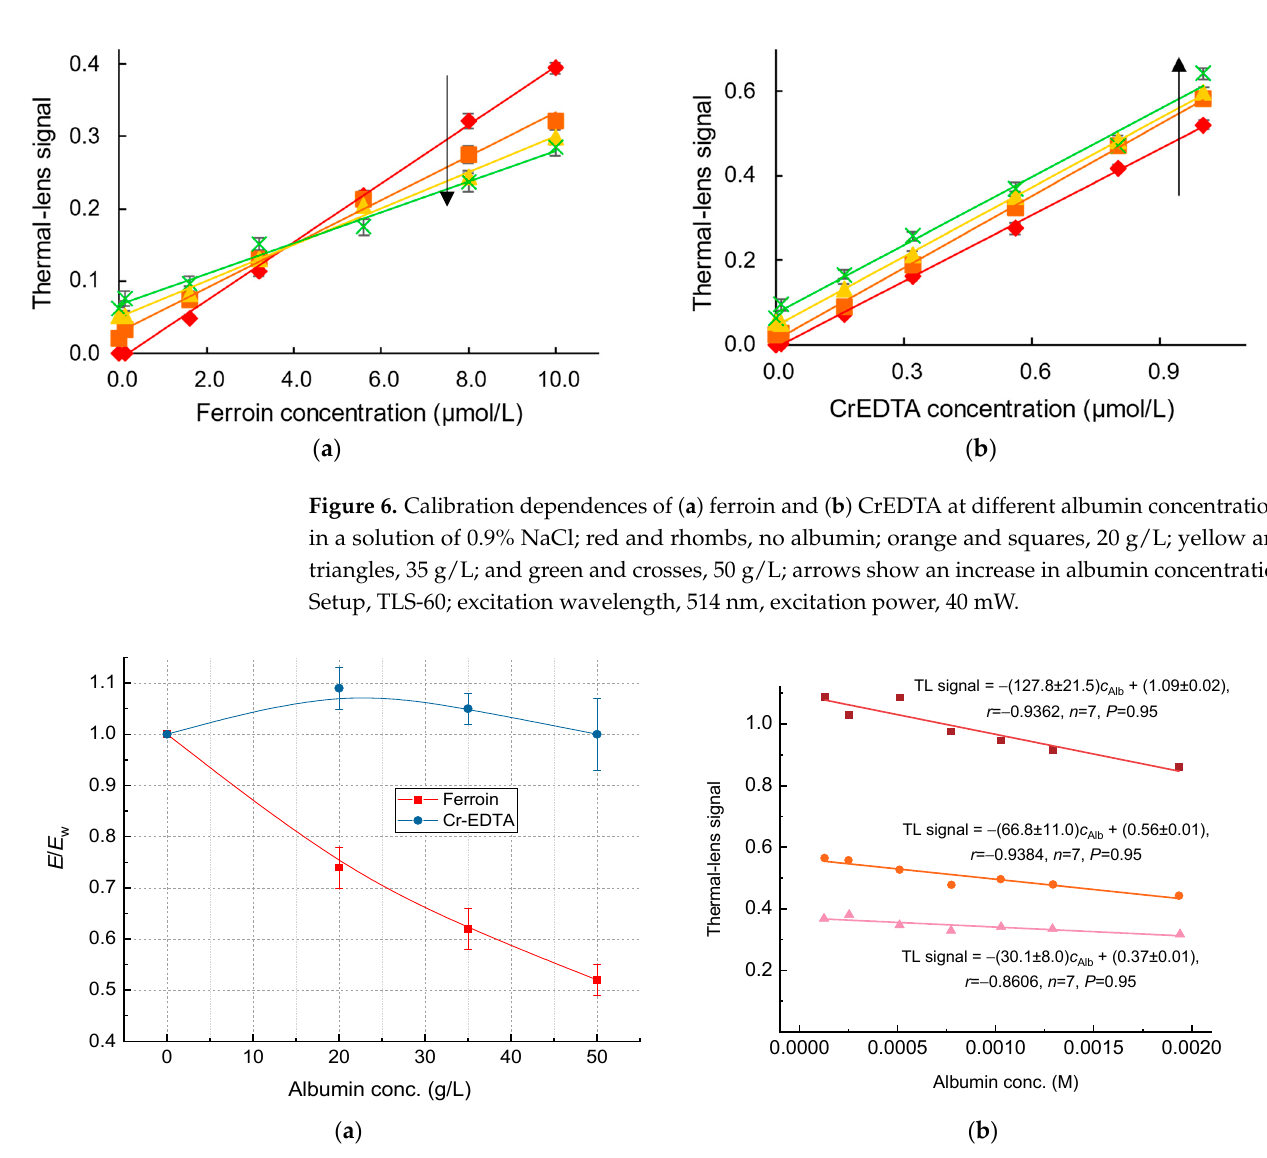
( b ) Figure 5. Dependences of the thermal-lens signal (setup, TLS-150; excitation wavelength, 532.0 nm) for myoglobin ( a ) on its concentration at 40, 70, 100, and 250 mW and ( b ) on the laser power for various myoglobin concentrations (in % w / w ). 3.4.3. Bovine Serum Albumin Albumins interact well with small molecules through electrostatic interactions. Thus, to change the properties of albumin, we used ferroin, which interacts well with this protein due to a pronounced positive charge, and the Cr(III) complex with EDTA (CrEDTA), which has a significantly lower charge density, i.e., it weakly interacts with albumin [124]. The modifying effect on the thermophysical parameters of albumin itself was estimated (Figure S3, Supplementary Materials). It shows a pronounced linear dependence on the concentration of albumin. At the wavelengths of excitation lasers, albumin does not absorb, which means that the signal increases mainly due to changes in thermal parameters.